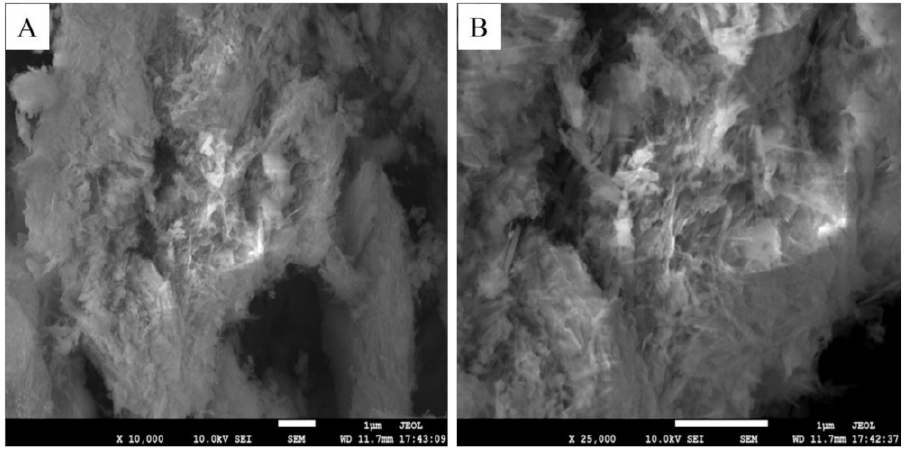
Figure 3. SEM morphology of 5V 2 O 5 /PG ( A ): × 10,000; ( B ): ×